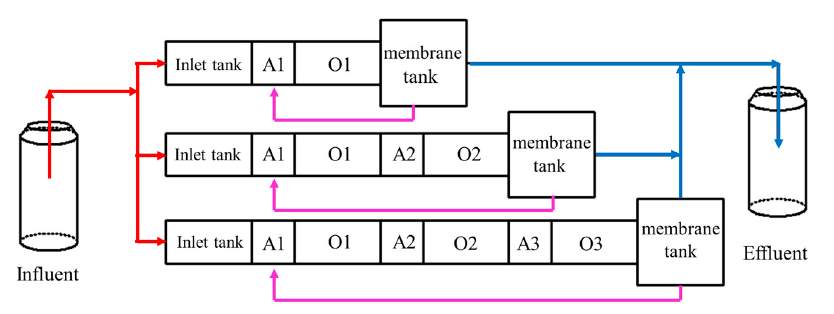
Figure 1. Overflow O-MAO-MBR process flow chart.